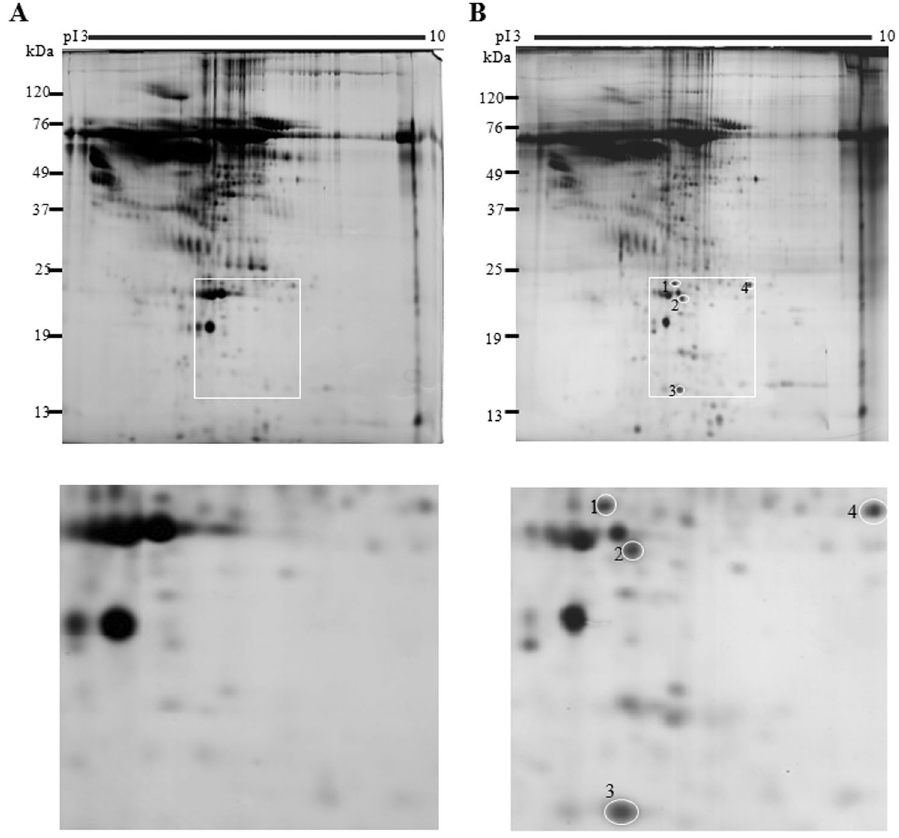
Figure 2. Secretome profiling of HCV replicon Con1 cell and Huh7 cells. ( A , B ) The conditioned medium derived from Huh7 ( A ) or Con1 ( B ) cells were collected as described in the Materials and Methods. The proteins that were present in the conditioned medium were separated by 2D-PAGE followed by silver staining of the proteins. The proteins that were differentially present in the conditioned medium from Huh7 and Con1 cells were labeled as 1, 2, 3, and 4 (upper and lower panels). The gel images for these four protein spots were enlarged as shown in the lower panel. These proteins were extracted from the gel and were identified by MALDI-TOF analysis.